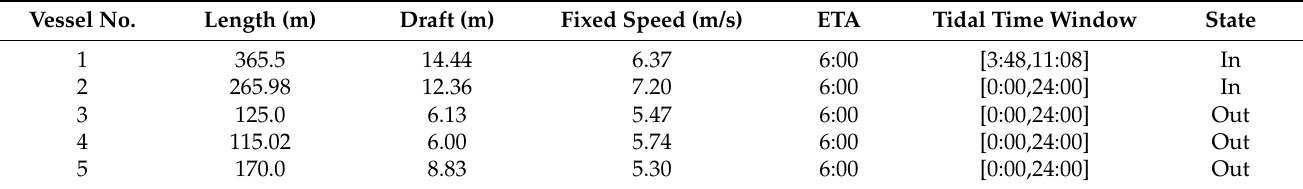
Table 3. Sample general VSP